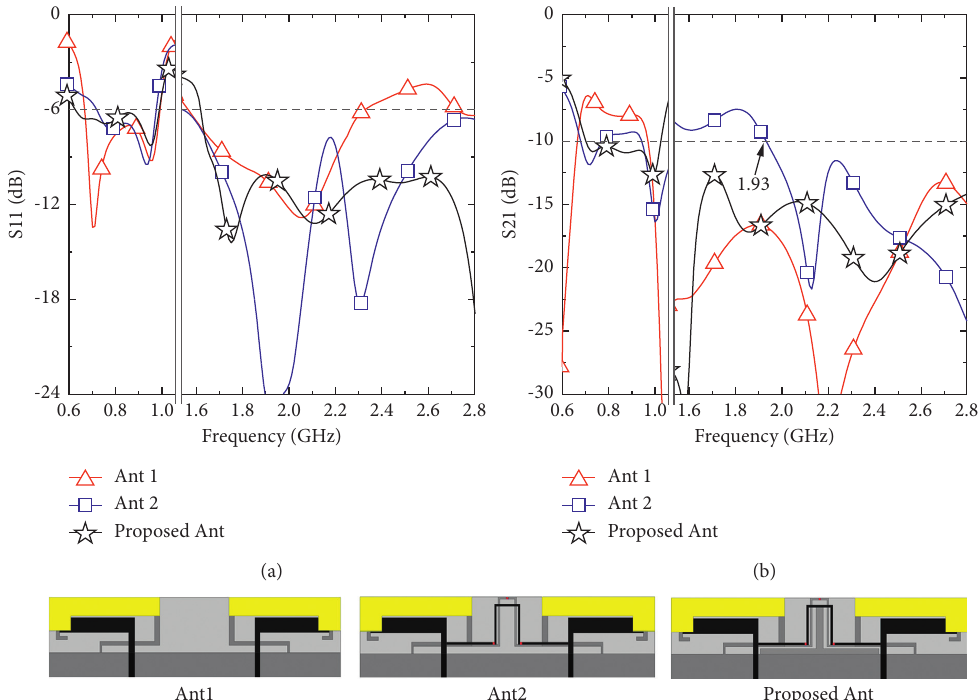
Figure 2: Simulated S-parameters of the Ant1 (without the two NLs and inverted-T branch), Ant2 (only with the two NLs), and the proposed Ant (with the two NLs and inverted-T branch). (a) S11. (b)